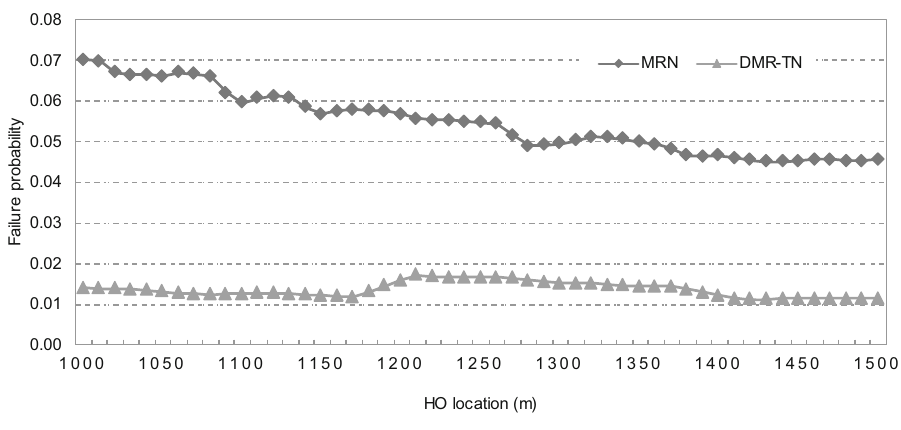
Fig. 8 HO failure probability